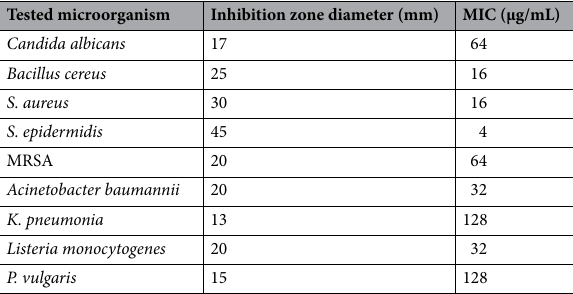
Table 3. The antimicrobial activity of the synthesized Au-NPs.